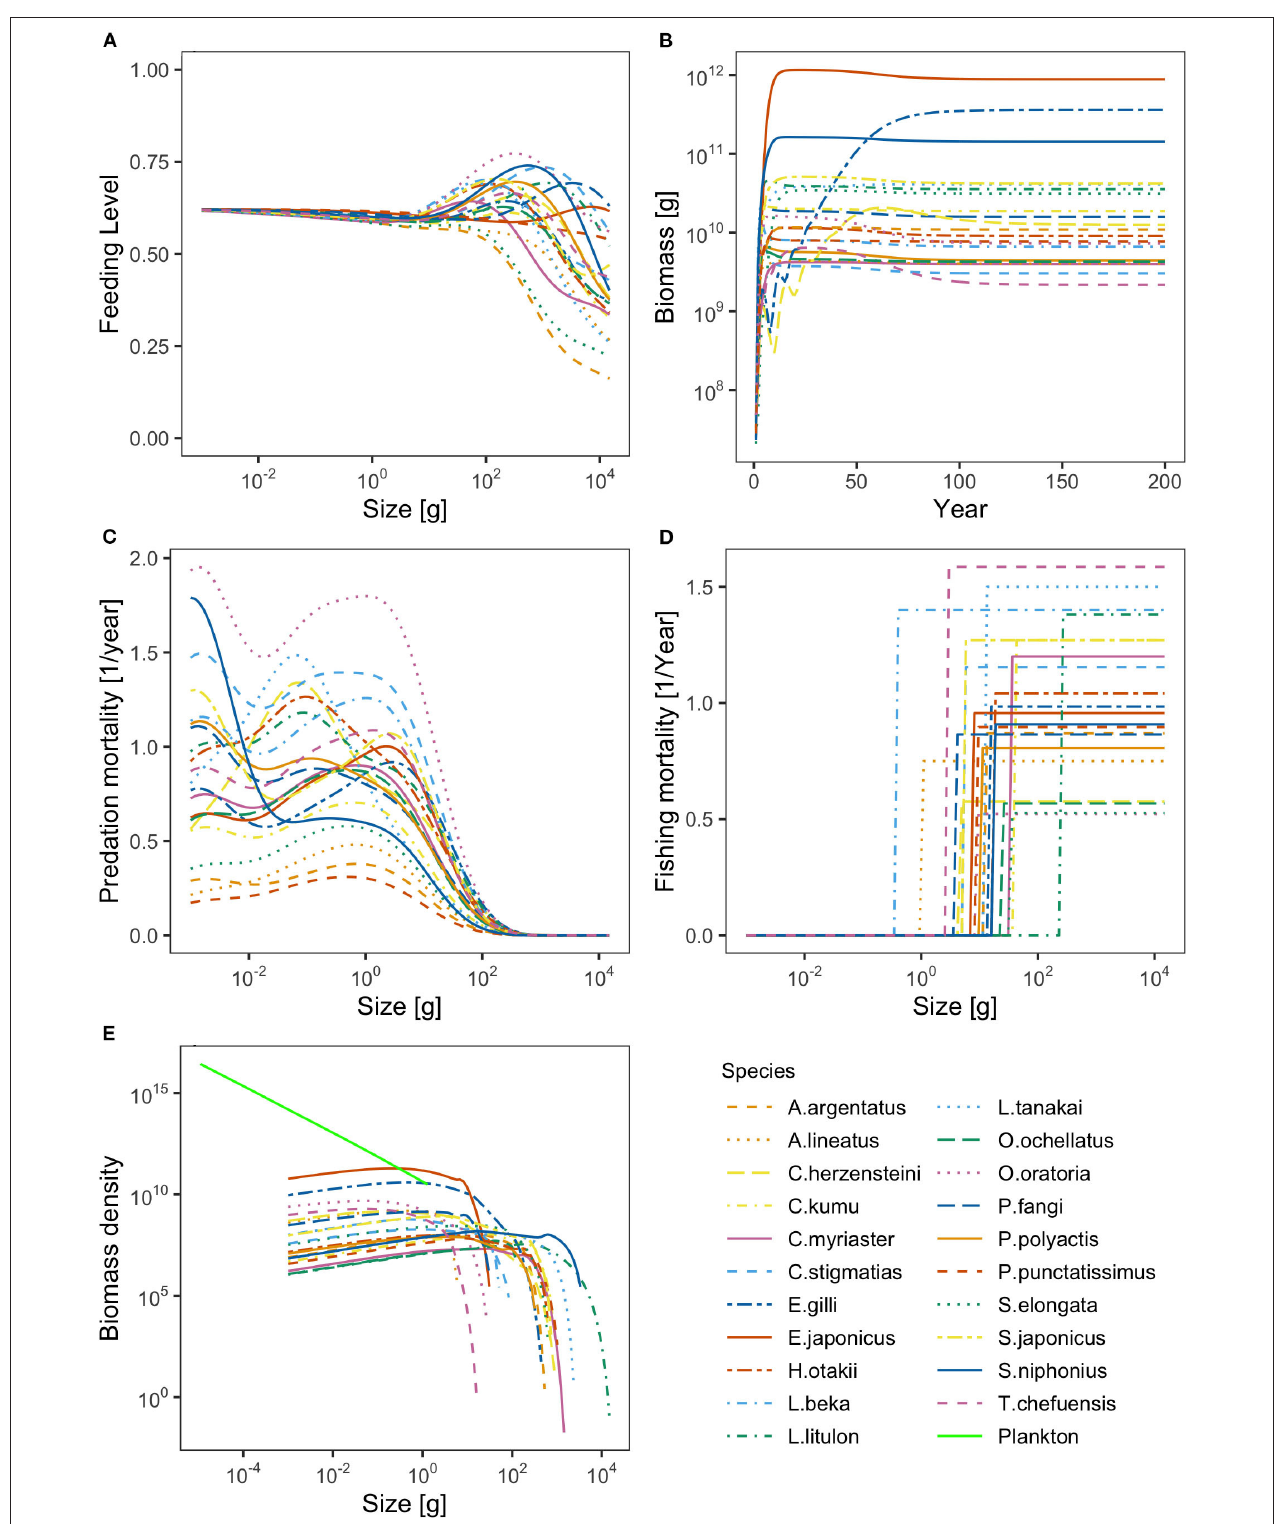
FIGURE 1 | A summary of the size-spectrum model outputs, including (A) feeding level, (B) species biomass through time, (C) predation mortality, (D) fishing mortality, and (E) community size spectra. The results were derived from the calibrated model in the coastal water of Shandong, projected for 200 years with constant fishing efforts. Each line denotes 1 of the 21 species included in the